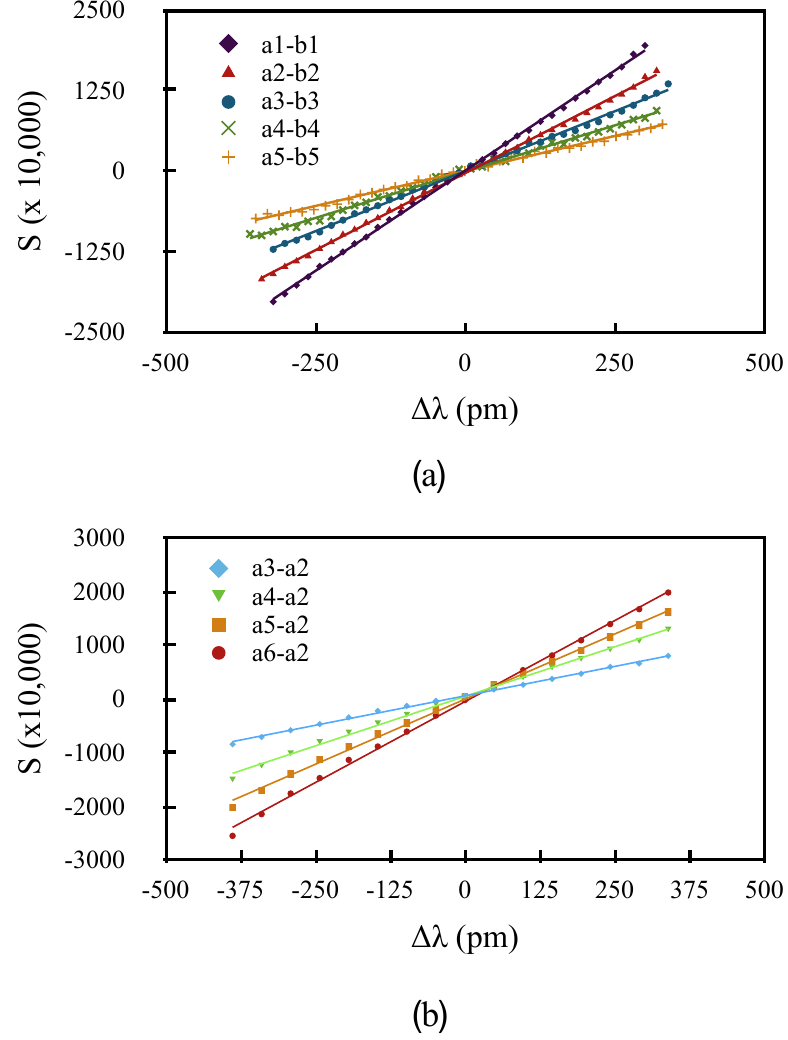
Figure 8. S vs. ∆ λ for ( a ) two-pulse scheme, and ( b ) one-pulse scheme illustrated in Figure